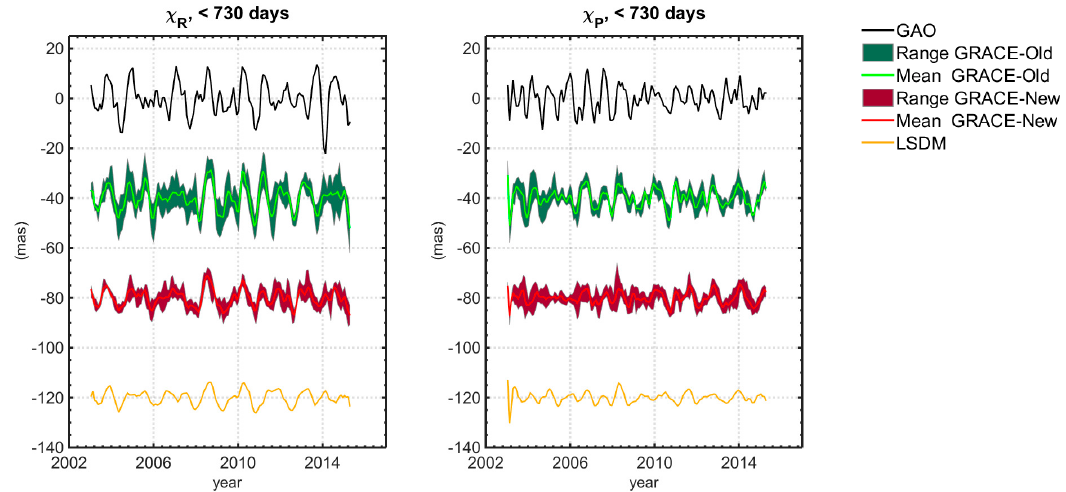
Figure 6. Comparison of mean value with ranges between minimum and maximum for χ R and χ P of short-term (<730 days) non-seasonal variation in HAM for old and new GRACE solutions. Time series of GAO and HAM from the LSDM are provided for comparison. The units are milliseconds of arc (mas). For better visibility, a bias was added to various HAM in order to shift them relative to each other.